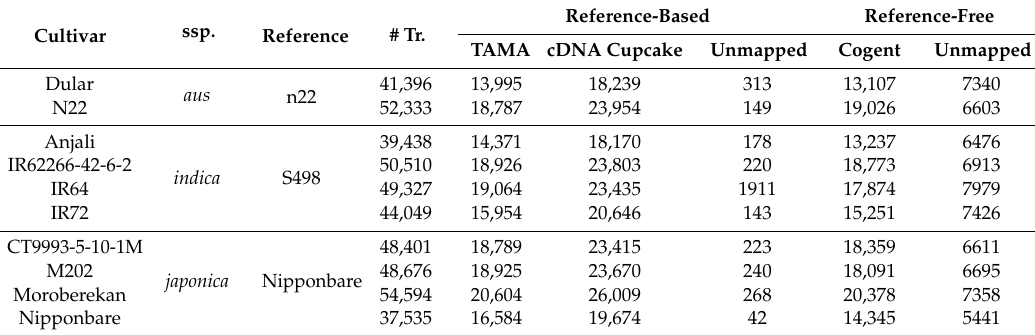
Table 3. Number of isoform models after collapsing with TAMA, cDNA cupcake and cogent. #Tr.—number of filtered, high-quality isoforms used for collapsing. Cultivars were sorted alphabetically within the subspecies (ssp.) aus , indica , and japonica . ssp. #